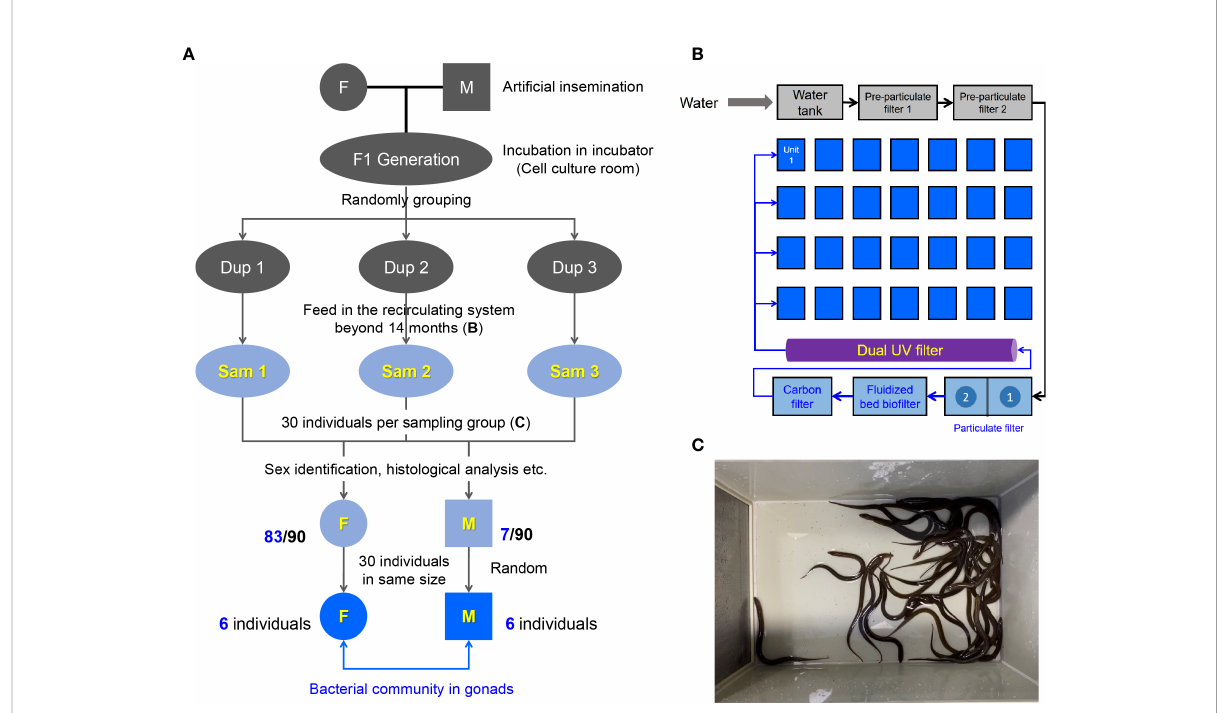
FIGURE 1 Design and sampling of this study. (A) Generation of sibling population in M. albus and experimental sampling design. (B) Schematic diagram of the recirculating system. (C) 30 individuals were randomly selected as the sampling group from the unit of the recirculating